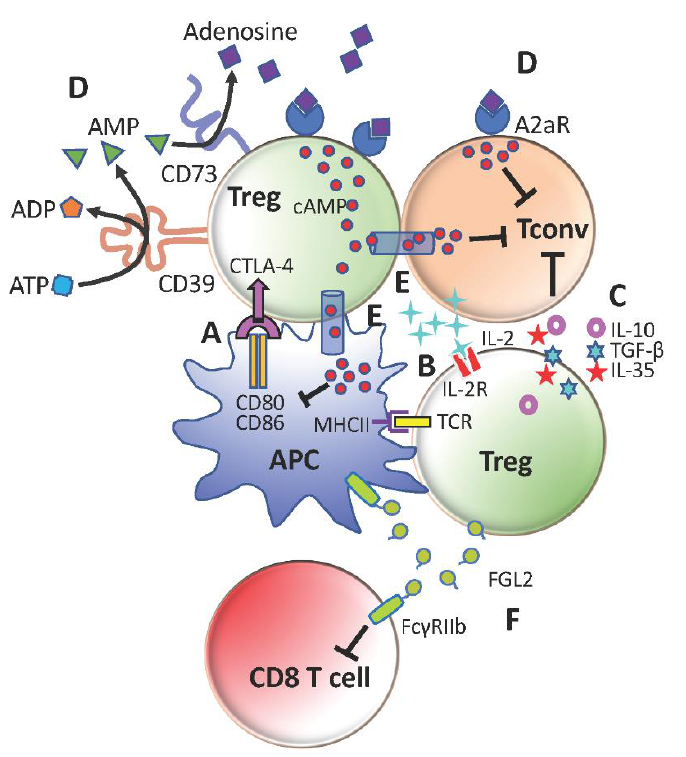
Figure 1. Immunosuppressive mechanisms of regulatory T-cells (Tregs). ( A ) Cytotoxic T-lymphocyte-associated protein 4 (CTLA-4)-mediated downregulation of CD80 and CD86 on antigen-presenting cells (APCs) to limit conventional CD4 + T-cells (Tconv) activation. ( B ) Compete with Tconv cells for IL-2 to restrict Tconv survival and proliferation. ( C ) Secretion of anti-inflammatory cytokines TGFb, IL-10 and IL-35 to promote Tconv exhaustion and repress Tconv effector functions ( D ) Generation of adenosine with CD39 and CD73 to suppress Tconv cells and further stimulate Tregs through A2aR ( E ) Transfer of cAMP to inhibit activation of Tconv cells and APCs ( F ) Production of FGL2 to inhibit CD8 + T-cells and APCs through Fc 𝛾 RIIb.